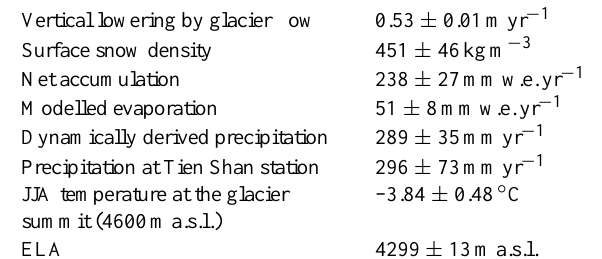
Table 3. Annual net accumulation, precipitation and summer mean (JJA) temperature required to maintain the present-day geometry of the Gregoriev Glacier. The snow density was measured from three snow pits excavated every year. Evaporation is the average of the model calculation for 29yr. Equilibrium line altitude (ELA) yielding zero specific mass balance is also shown.